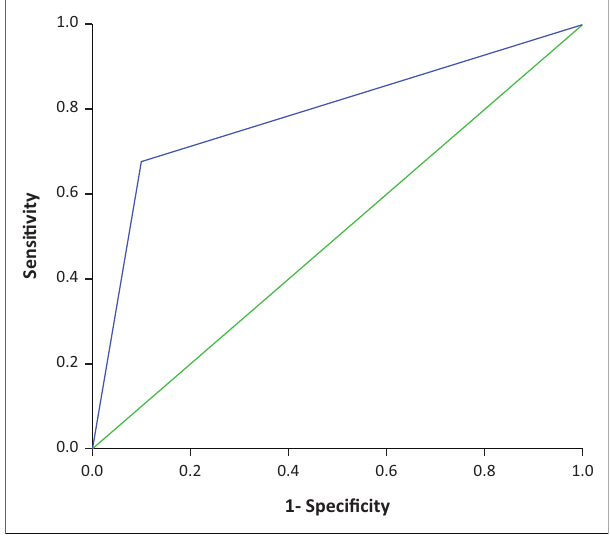
Note: Diagonal segments are produces by ties. ROC, receiver operating characteristic. FIGURE 4: Red cell distribution width ROC curve in haemoglobin SS phenotypes in western Kenya, 01 Janauary 2015 – 31 December 2020. This ROC curve demonstrates the efficacy of RDW at 21.1 % optimal point in SCD (Haemoglobin SS) phenotypes diagnosis.